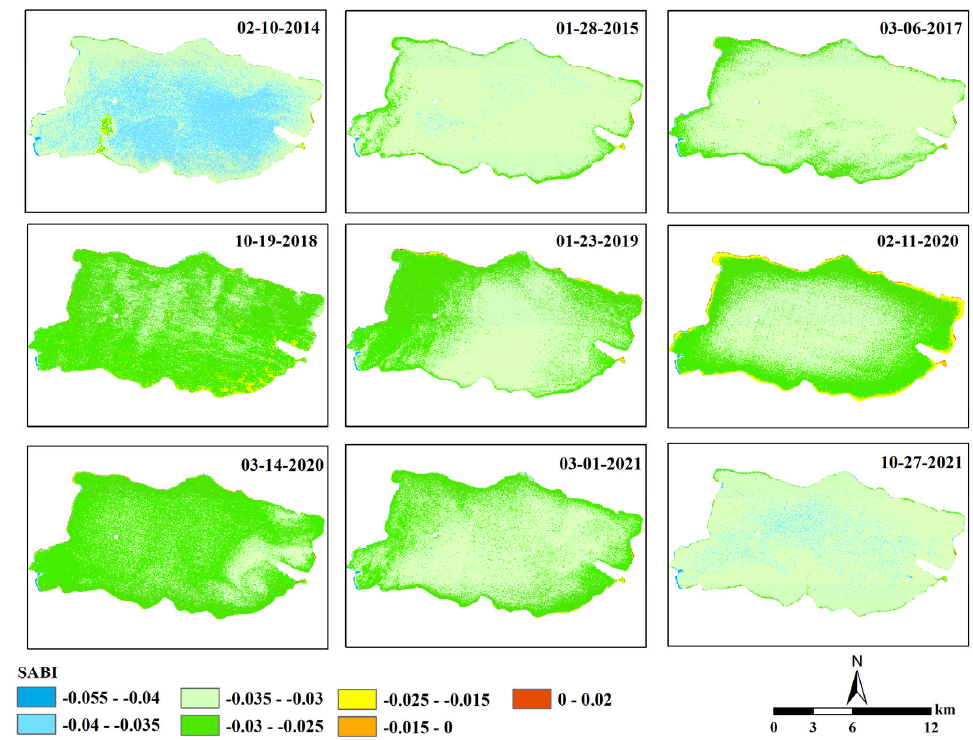
Figure 4. Spatial distribution of SABI in Lake Villarrica.